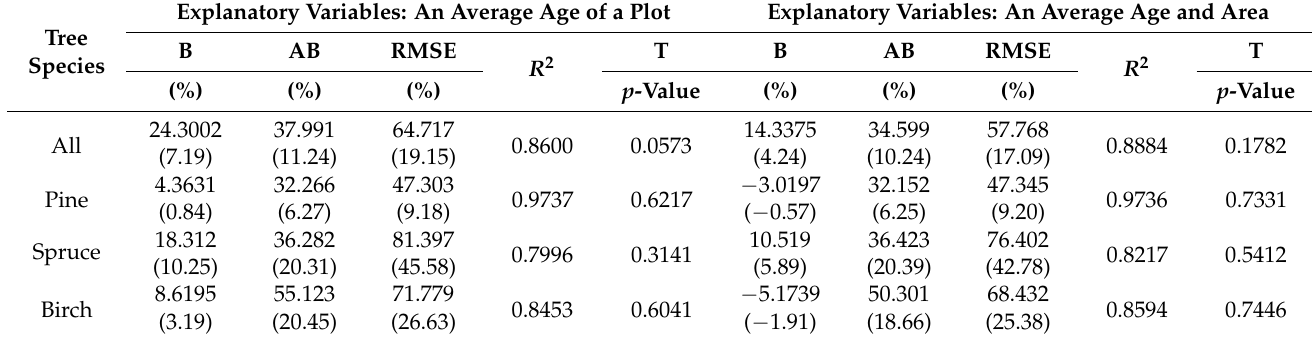
Table 8. Statistical measures and p -values of the Student’s t -test for the predictions of the mean tree basal area (whole-stand scenario).